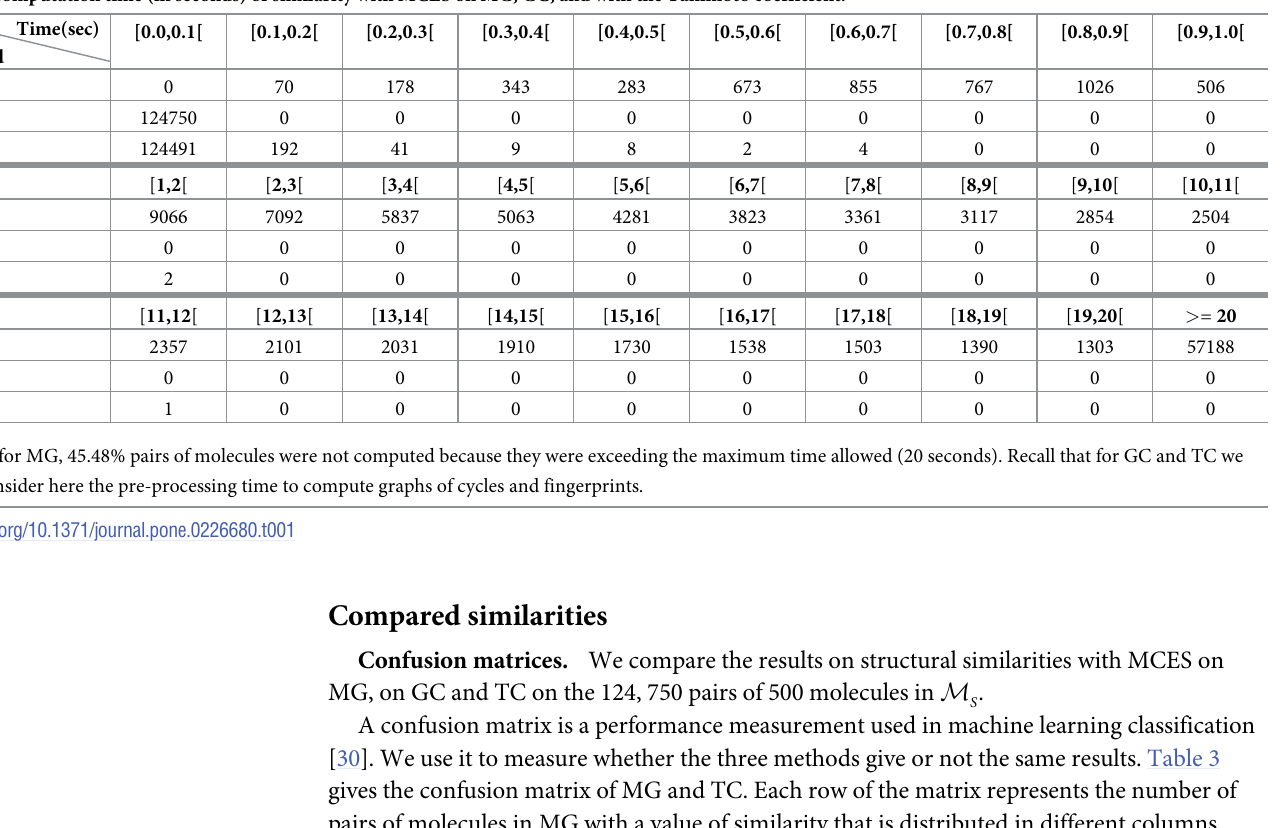
Table 1. Computation time (in seconds) of similarity with MCES on MG, GC, and with the Tanimoto coefficient. Method